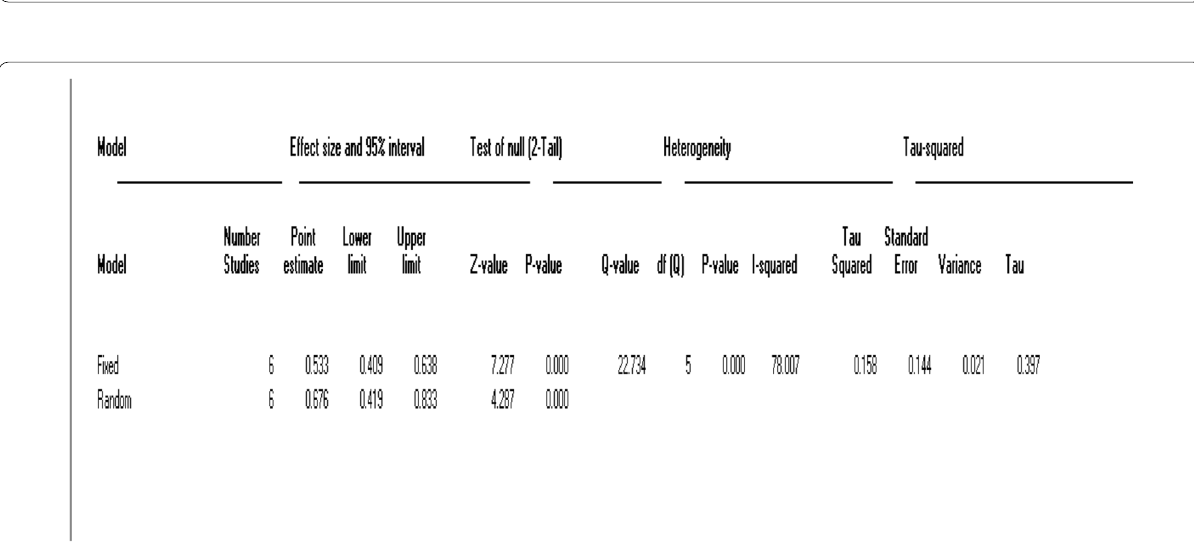
Fig. 7 Effect size model for heterogeneity estimated in